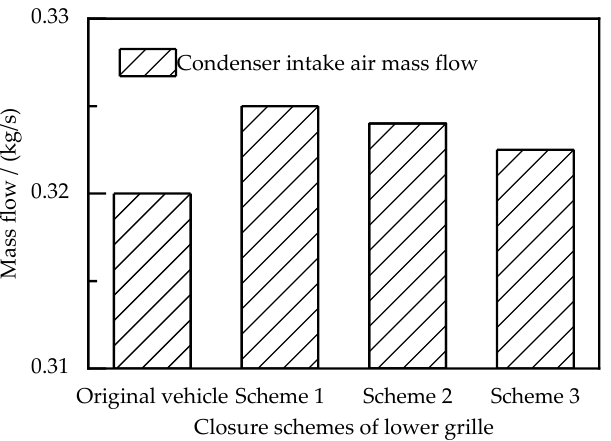
Figure 25. Comparisons of air side mass flow of condenser under different closure schemes of lower grille.